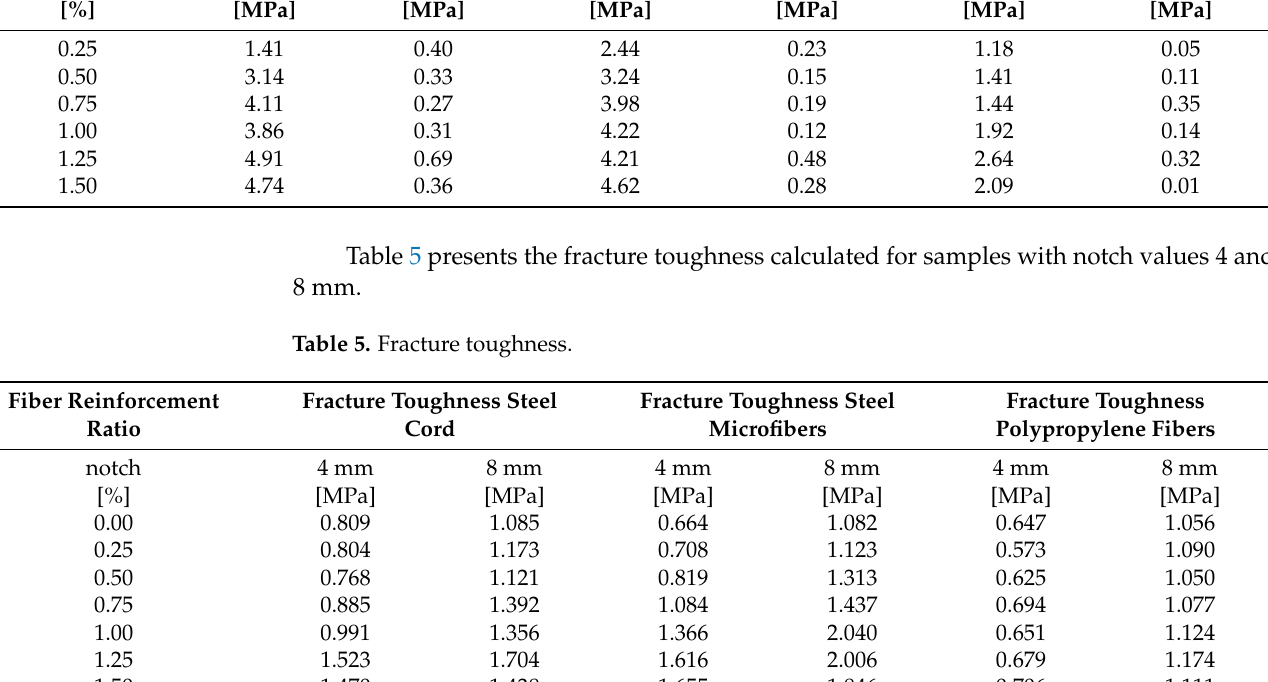
Table 4. Flexural toughness factor [60].